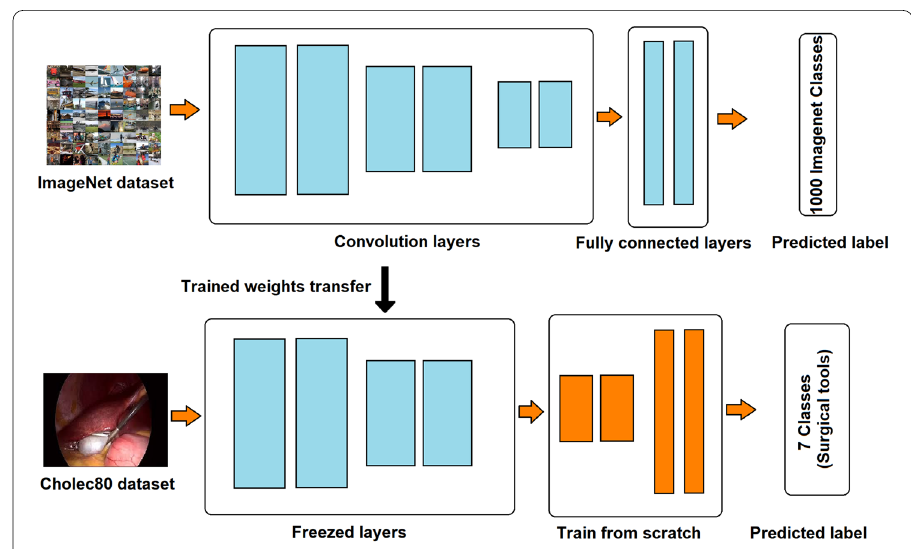
Fig. 7 Illustration of fine-tuning a convolutional neural network pretrained on ImageNet